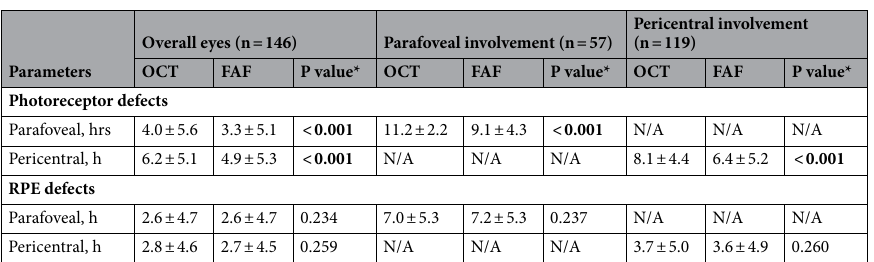
Pericentral involvement (n =